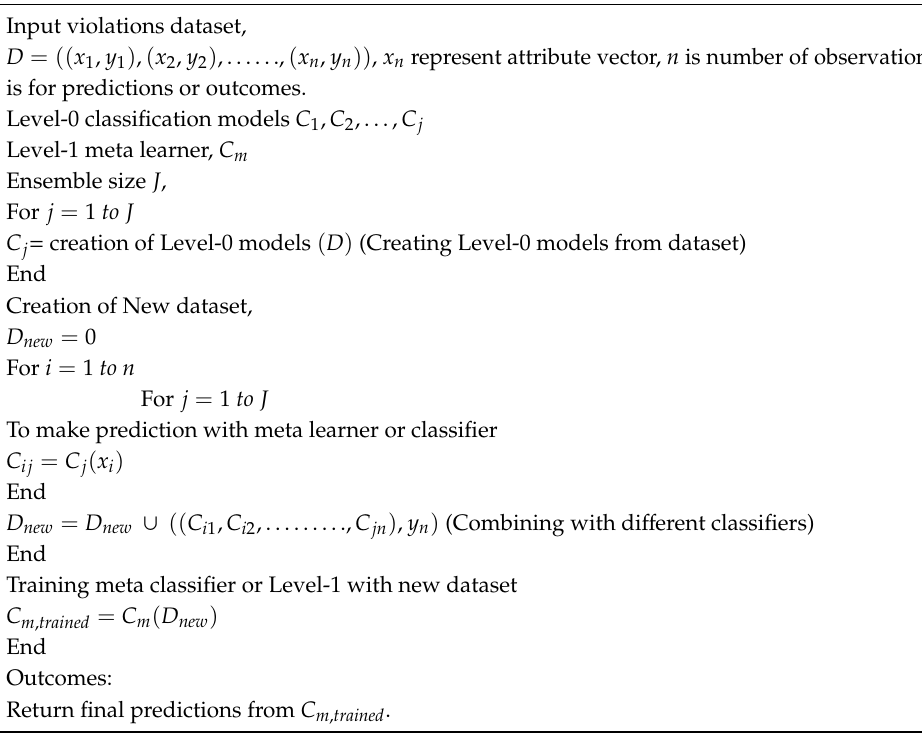
Algorithm 1. pseudo code of stack